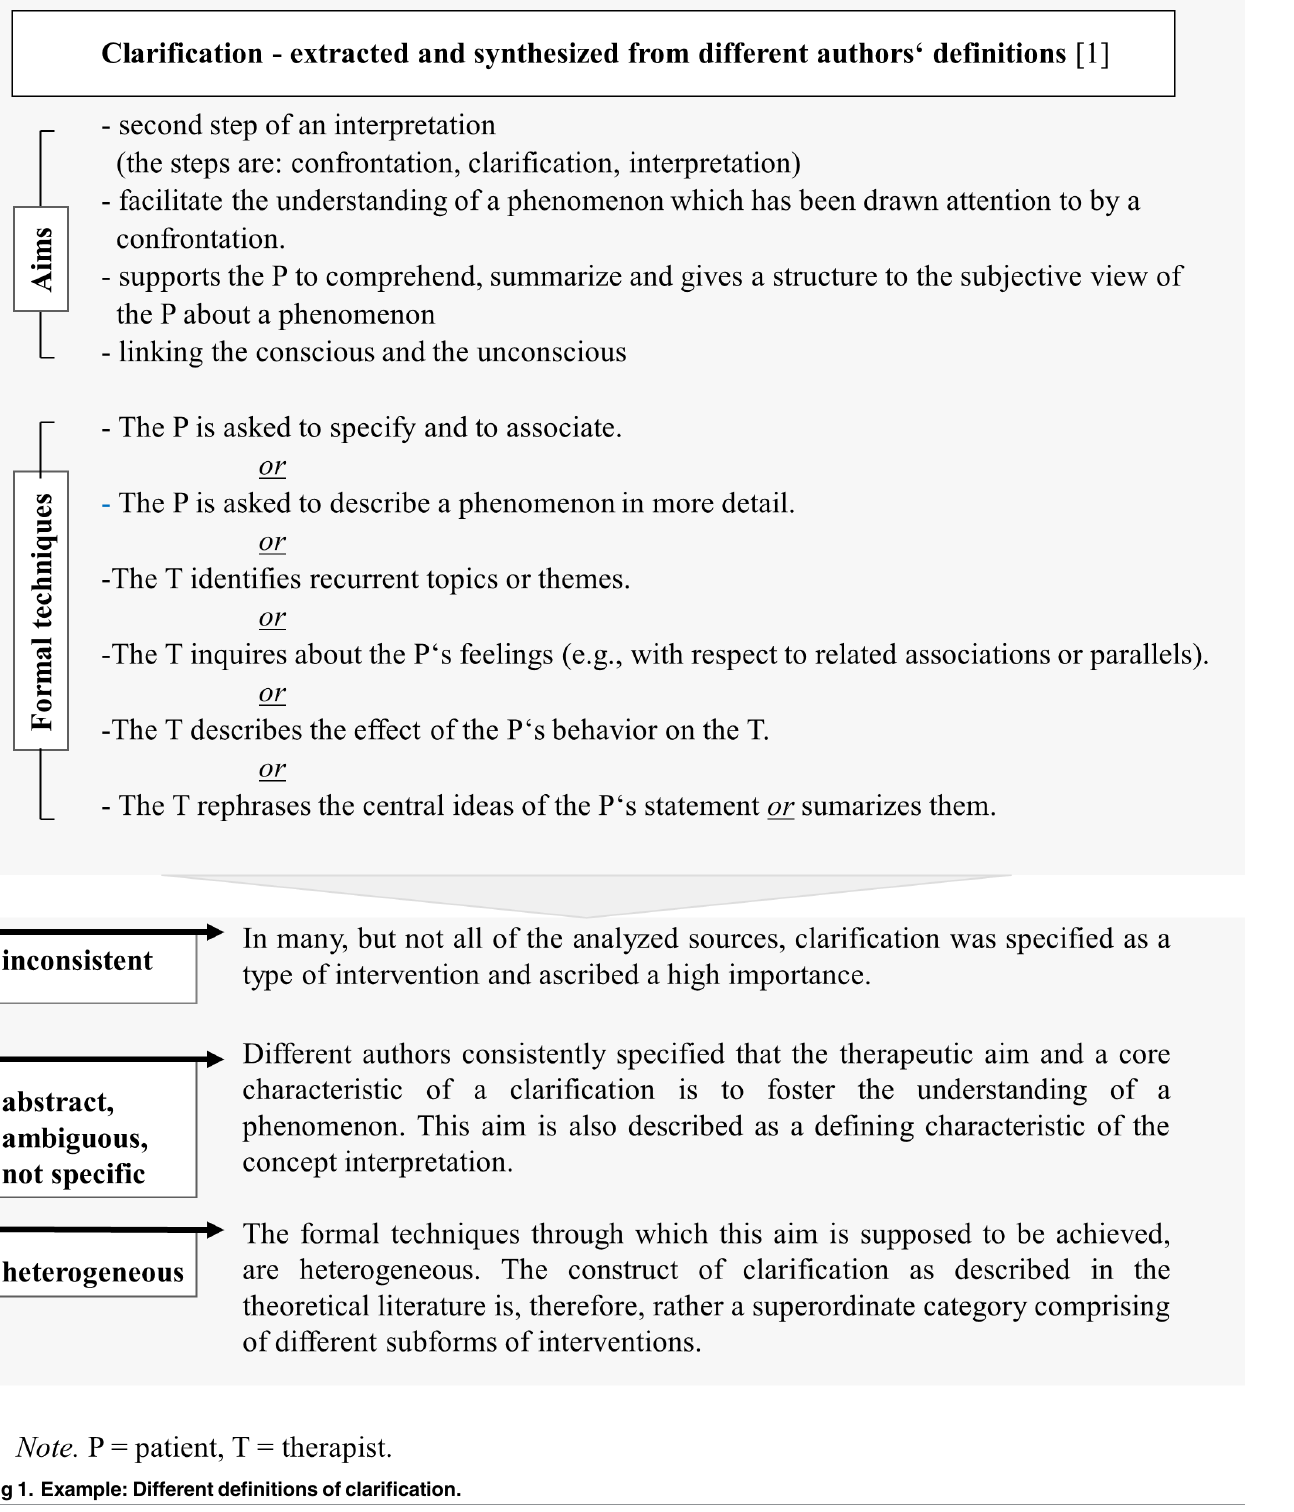
Fig 1. Example: Different definitions of clarification.